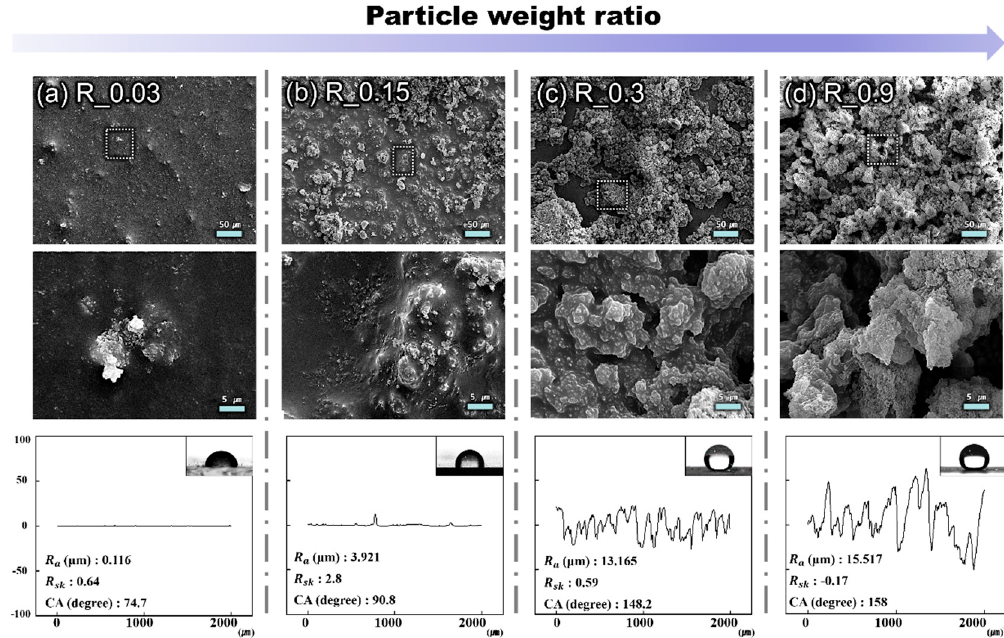
Figure 2. SEM images, roughness profiles and contact angle images of the surface with different weight ratios of the particles to the binder of ( a ) R_0.03, ( b ) R_ 0.15, ( c ) R_ 0.3, and ( d ) R_0.9.